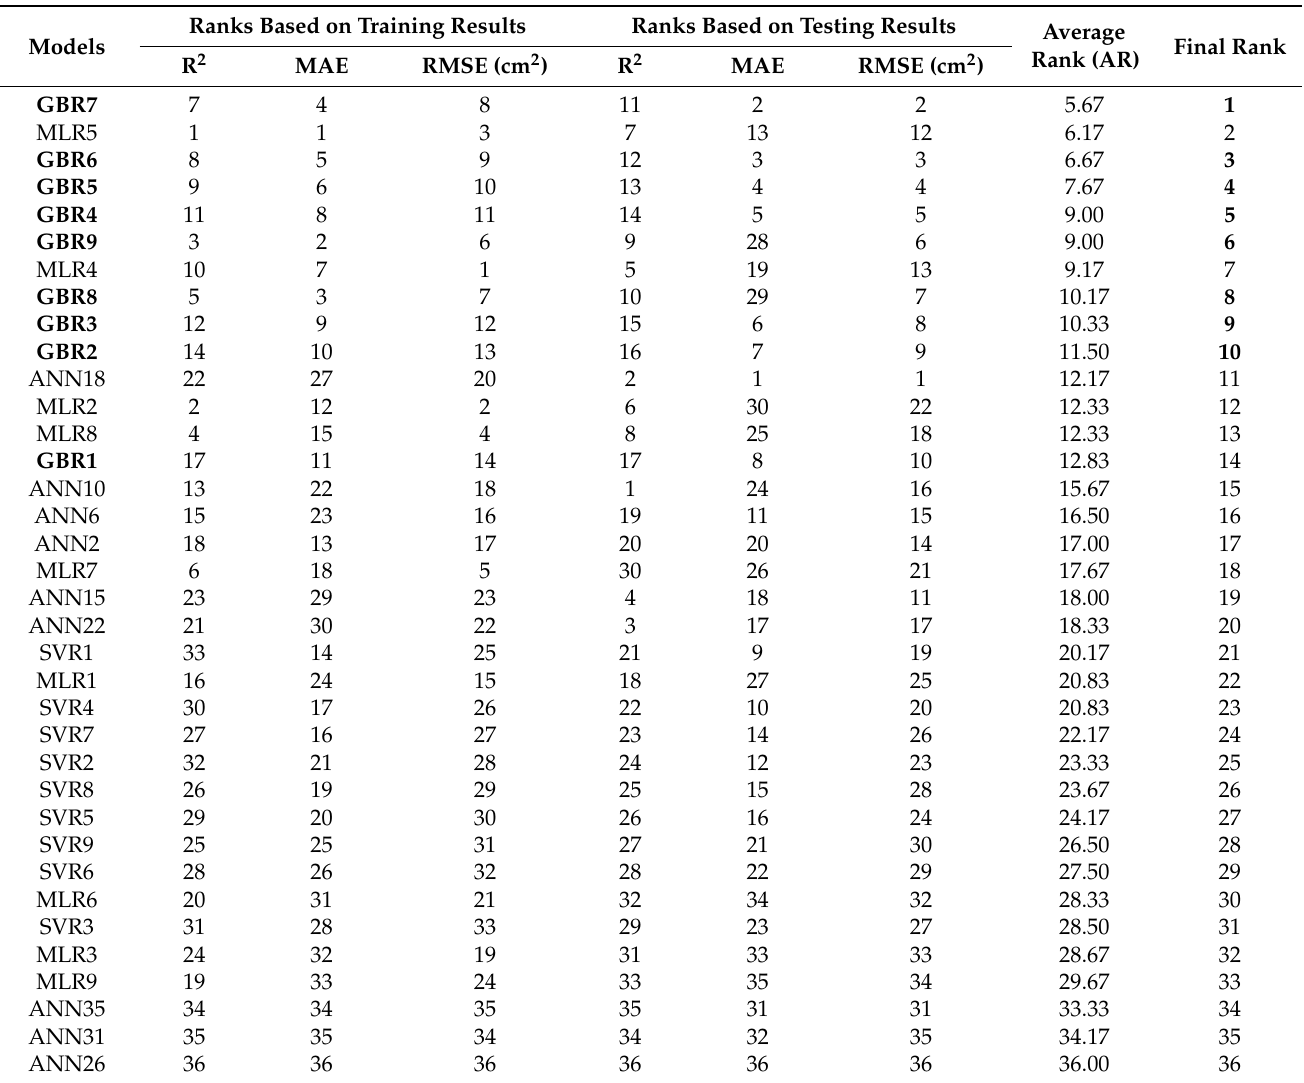
Table 9. Comparative statistical performance analysis of MLR, SVR, ANN, and GBR based on average rank (AR) ranking